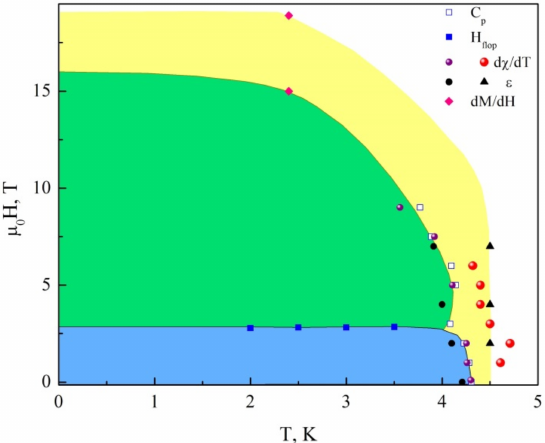
Figure 6. Magnetic phase diagram in PbCu(SeO 4 )(OH) 2 as derived from measurements of magneti- zation M , specific heat C p and dielectric permittivity ε .